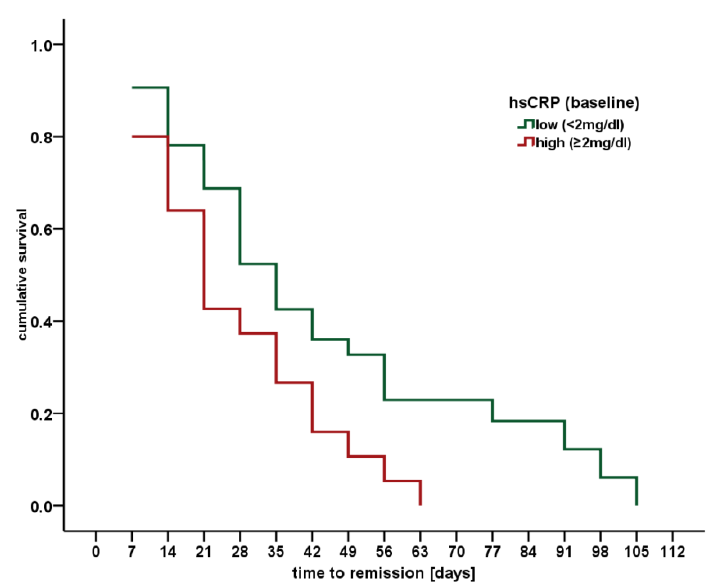
Figure 2. Kaplan-Meyer survival function of time to full remission of MDD for hsCRP status. Estimated likelihood of full remission (HAM-D17 score < 7) based on Mantel-Cox’s regression analysis for hsCRP concentrations at baseline in patients suffering from MDD. Time to full remission was significantly shorter in patients with elevated baseline hsCRP concentrations.